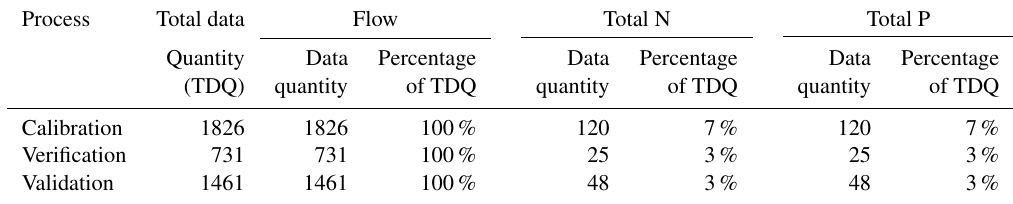
Table 3. The amount of data available from the State Environmental Monitoring and IMGW for selected catchments. TDQ: total data quantity.